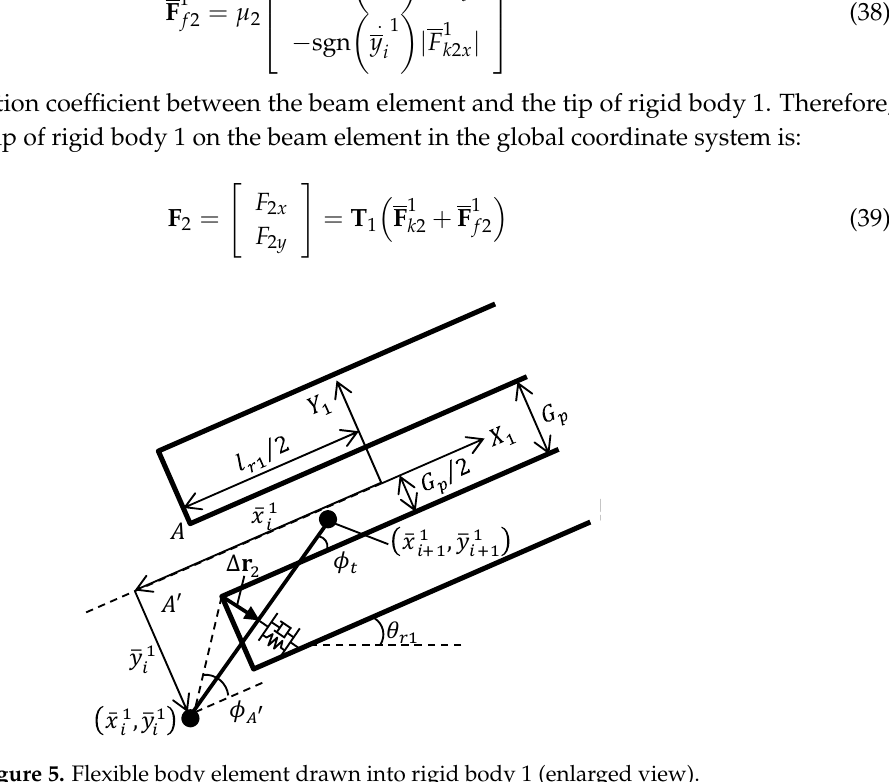
Figure 5. Flexible body element drawn into rigid body 1 (enlarged view).